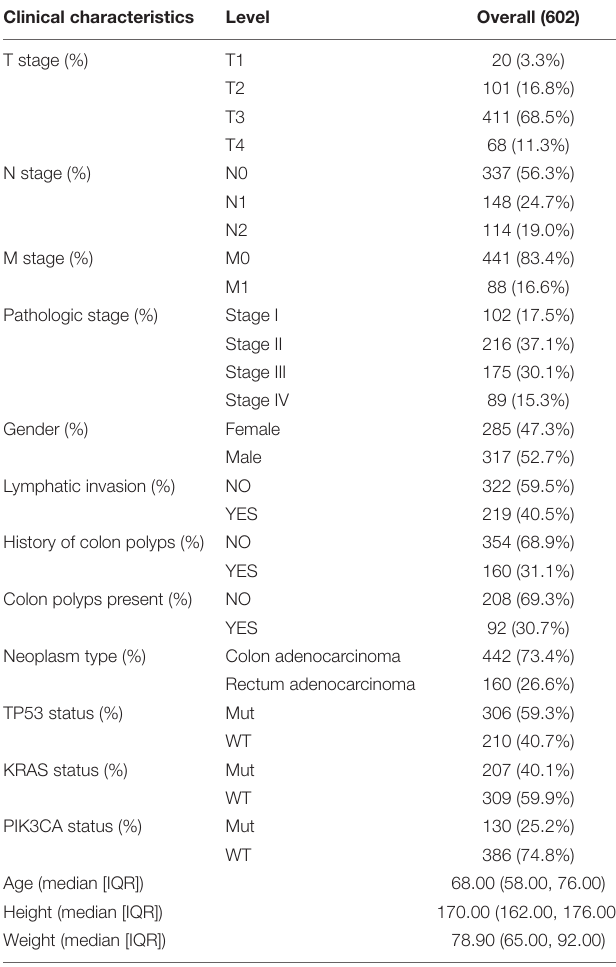
TABLE 1 | TCGA colorectal cancer patient characteristics. Clinical characteristics